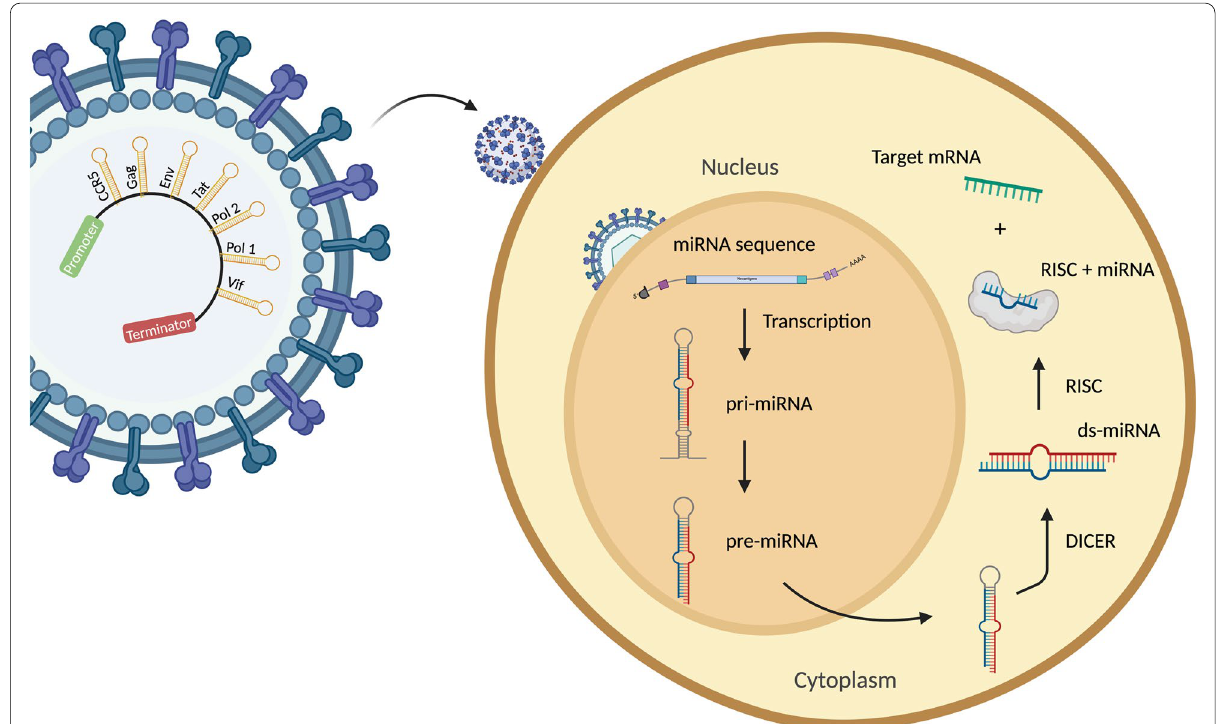
Fig. 4 The schematic view of multiplexed shRNA-miRs (note that the amount and combination of shRNA are flexible) and the mechanism of it in silencing genes. Env-pseudotyped lentiviral vector containing multiplex shRNA-miRs integrates with CD4 T cell, transducing the miRNA-based shRNA into the nucleus. It is then transcribed into primary miRNA that is further cut into precursor miRNA and being transported out to the cytoplasm. The DICER cuts its loop head, and the produced double-stranded miRNA is unwounded by the RISC into a single strand that guides the RISC to cut the target mRNA. Target mRNA will be degraded and results in a gene